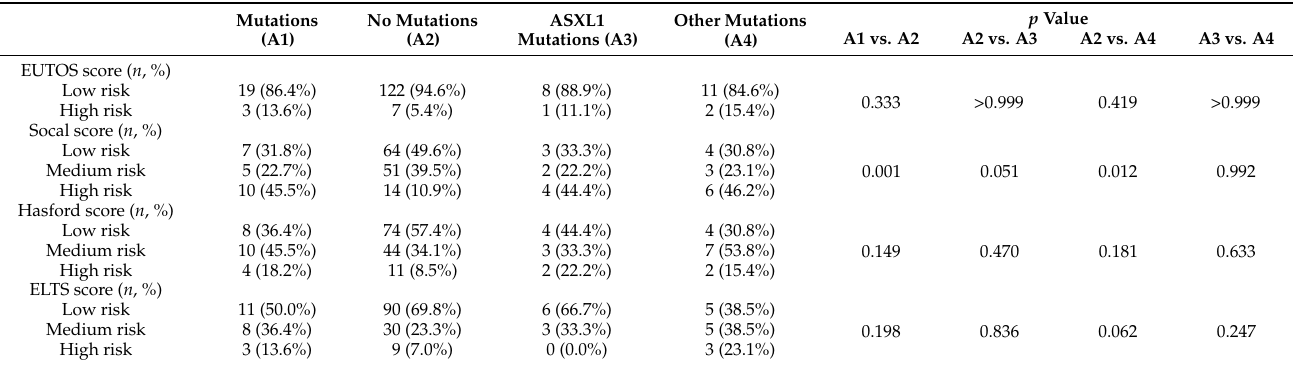
Table 7. Analysis of scoring systems on the mutations status of 151 CML-CP